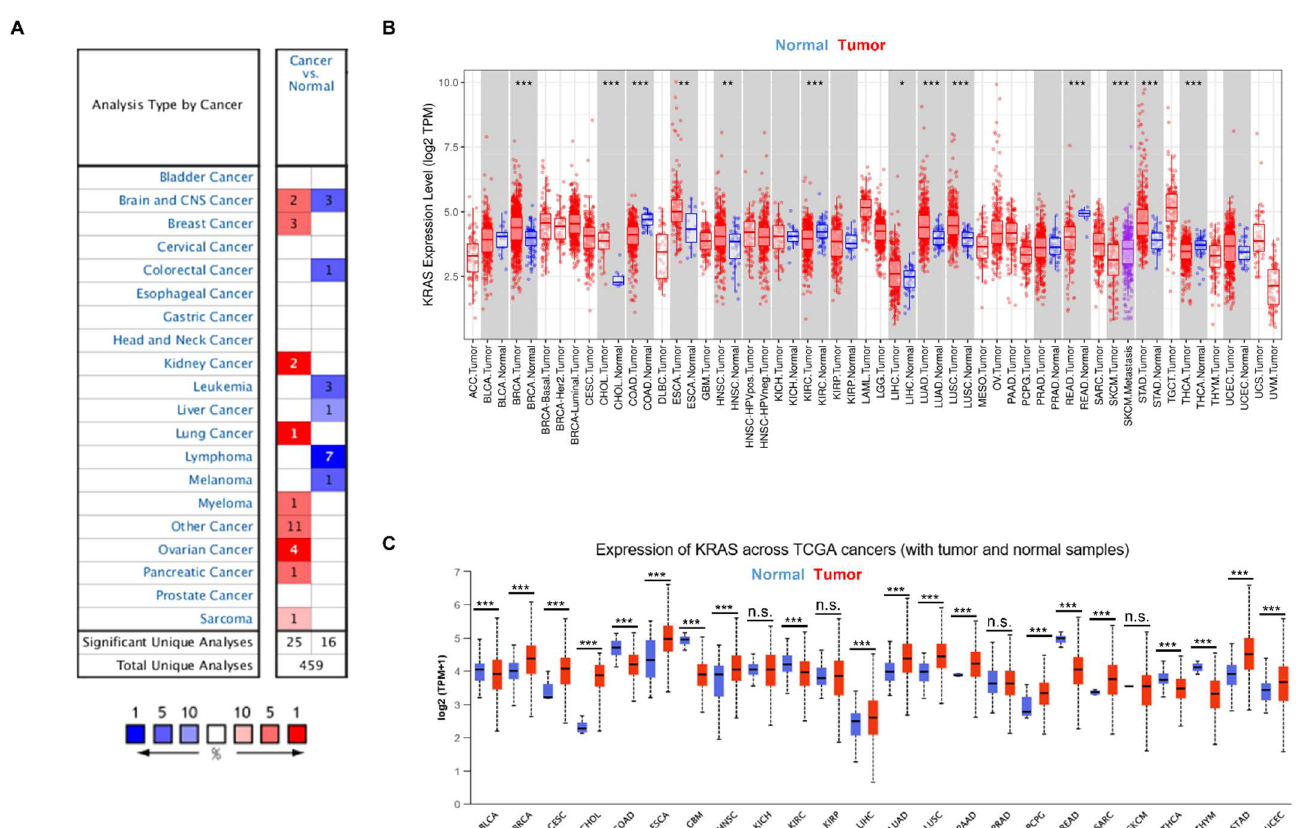
Figure 2. KRAS expression in multiple cancers. A , High or low expression of KRAS in different cancer tissues compared with normal tissues from the Oncomine dataset. The numbers in each cell indicate the number of datasets in each cancer type. B and C , Human KRAS expression levels in different types from TCGA data in TIMER ( B ) and UALCAN ( C ). p -value * < 0.05, p -value ** < 0.01, p -value *** < 0.001.